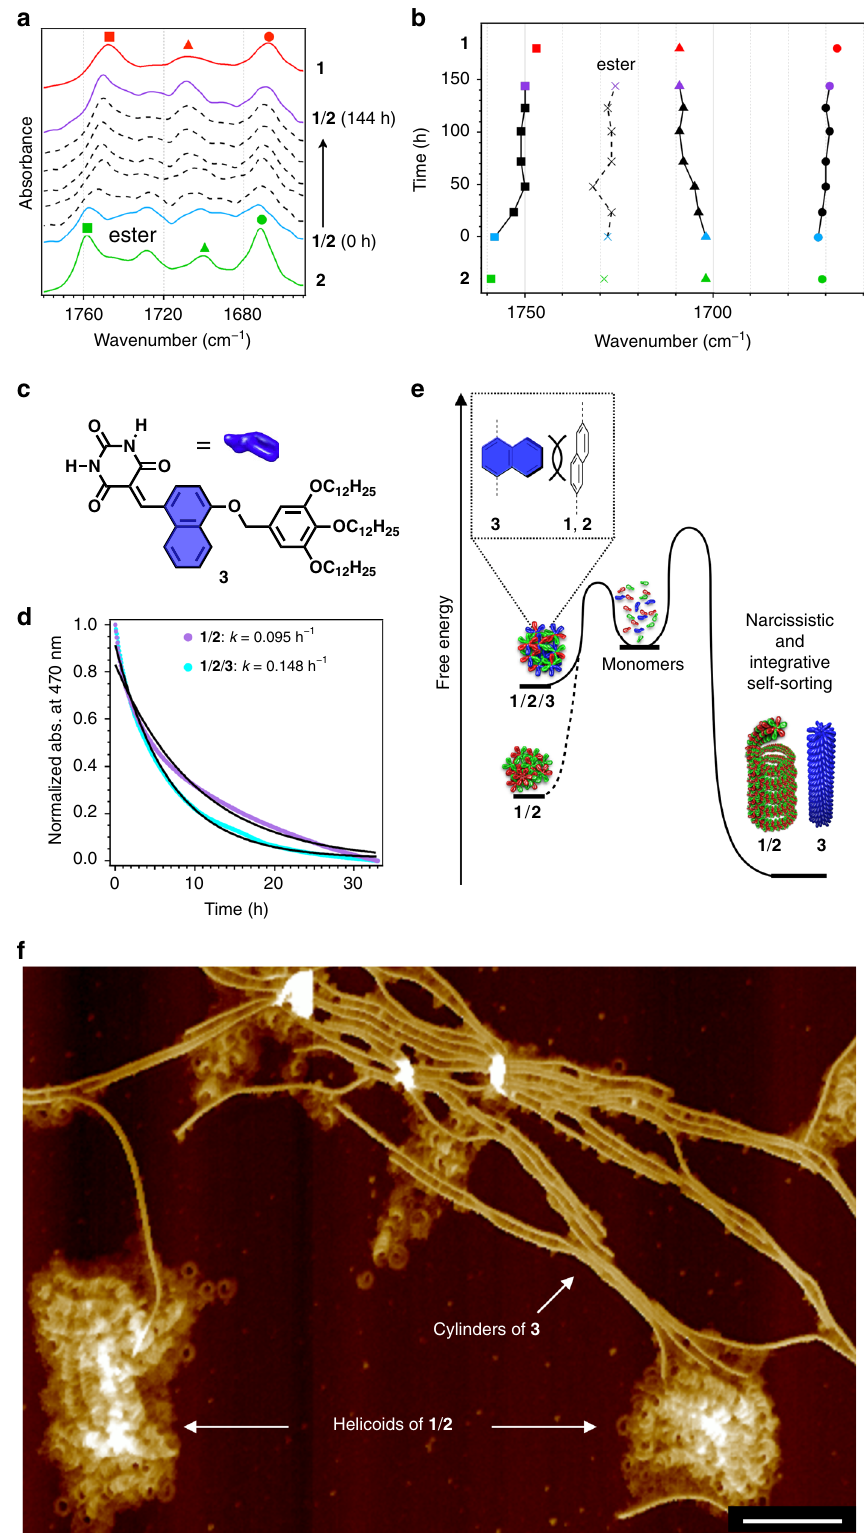
Fig. 3 IR analysis and modulation of supramolecular copolymerization. a IR spectra of toroids of 1 (red), linear fi brils of 2 (green), and a series of spectra showing the time-dependent spectral change of 1 / 2 ( c t = 500 µ M) from amorphous coaggregates (blue) to helicoids (purple). b Plots of the position of the maxima of the C = O stretching vibrations as a function of time (h). The colors and shapes of the symbols correspond to those in a . c Chemical structure of 3 . d Plots of the change in the normalized absorption at 470 nm for 1 / 2 / 3 (blue; c t = 150 µ M) and 1 / 2 (purple; c t = 100 µ M) at 20 °C after cooling. e Qualitative energy landscapes of the 1 / 2 and 1 / 2 / 3 systems. f AFM image of 1 / 2 / 3 after 24 h of aging. Scale bar, 100